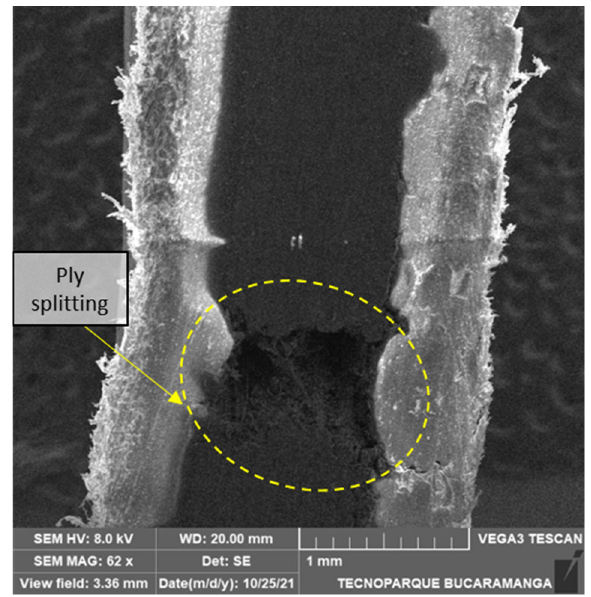
Figure 14. SEM transversal cut of a 6/16 carbon layers 45° flat printed sample.